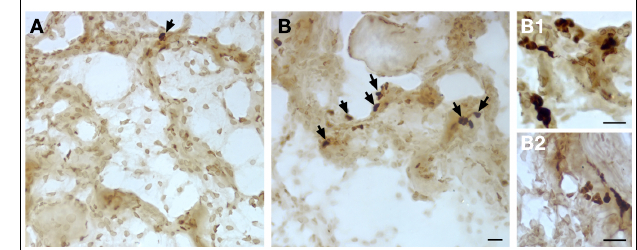
FIGURE 2 |A β deposits (arrows) detected in choroid plexus fromAD patients. (A) Choroid plexus tissue from age-matched control patient; (B) Choroid plexus from an AD patient. (B1,B2) High magnification of the A β deposits from AD patients. Scale bar = 20 μ m, n = 3 per group, ≤ 10 fields observed from each